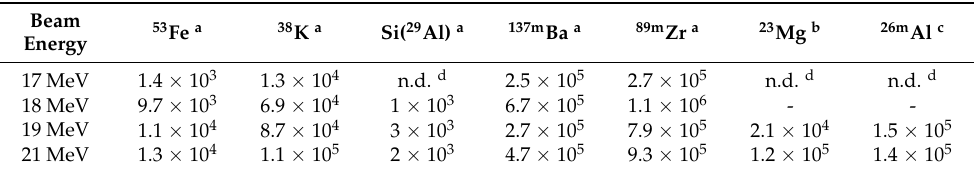
Table 2. Variation of the normalized reaction rate R n (Bq g − 1 µ A − 1 ) of the analytical photoactivation products with the beam